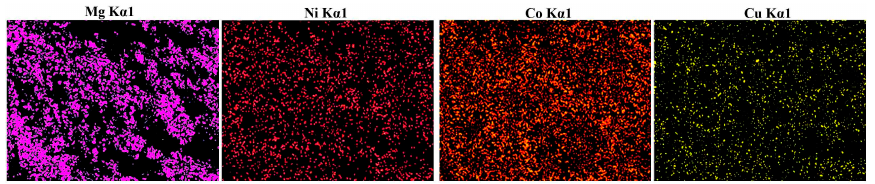
Figure 10. SEM images and elemental scanning maps of the sample separated once.